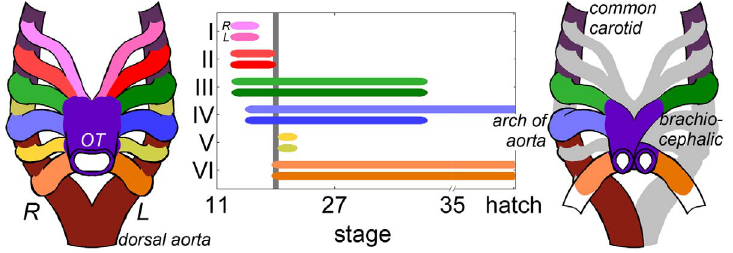
Figure 1. Timeline and schematic of the AA derivatives in the chick embryo. The timeline depicts the duration of the connection between the heart and descending dorsal aorta, where line width is an approximation of the frequency that the AA is present. The time axis is skewed to highlight the early stages investigated in this study. Though AA V is included here, it never truly connects to the dorsal aorta. The gray line designates stage 21, where up to four AA can be present. The schematic on the right depicts the mature avian great vessel pattern, where gray represents embryonic AA sections that disappear prior to the final arch configuration.